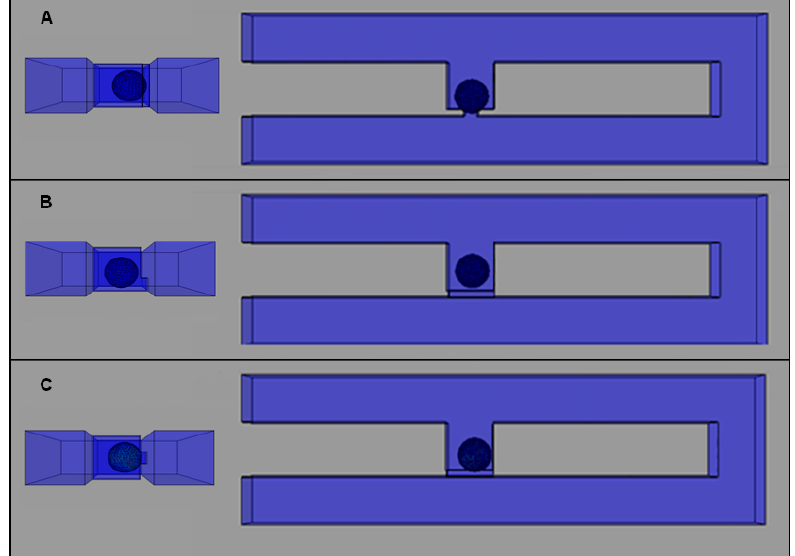
Figure 8. Cell trapping results at simulation time of 34s for cell trapping model with the same trap hole size (2, 7 and 7 μ m of W , L and H , respectively) for an Rh Main / Rh Trap ratio of 3.5 at three different positions: ( A ) model A; ( B ) model B; and ( C ) model C. ( Left ) side view; ( right ) top view of the model.